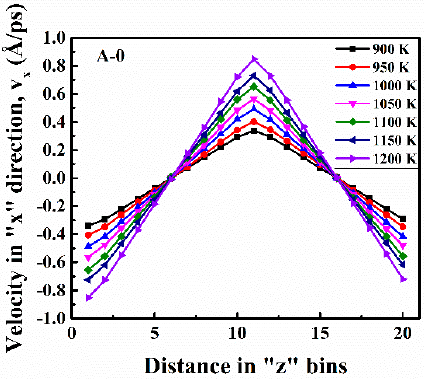
Figure 11. Velocity profile of A-0 at different temperatures.